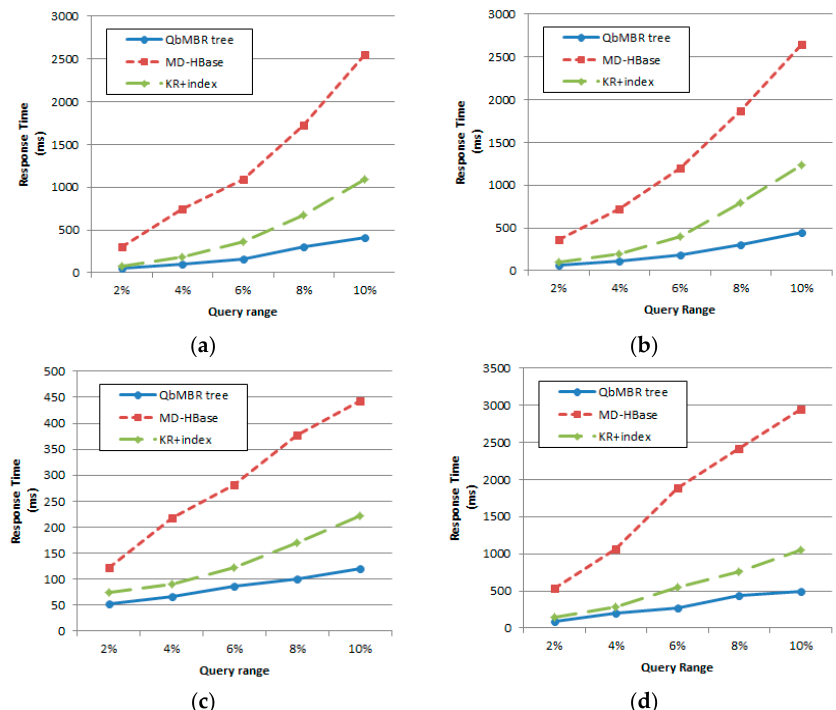
Figure 10. Effect of query radius on response time: ( a ) Synthetic dataset with uniform distribution; ( b ) Synthetic dataset with normal distribution; ( c ) European POI dataset; ( d ) OpenStreetMap dataset.